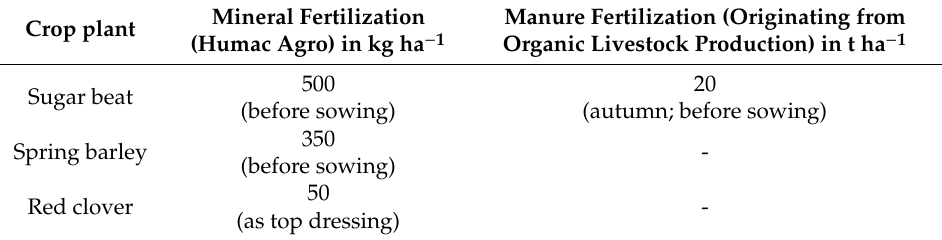
Table 3. Fertilization applied in the organic